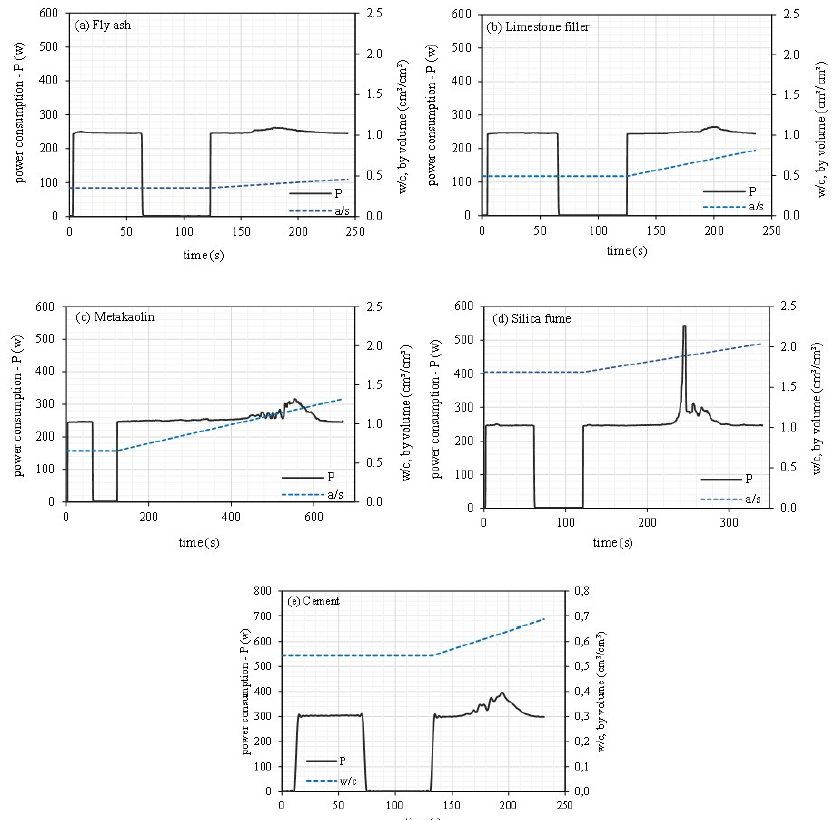
Figure 9. Mixing energy test results, with 0.5ml/s water additions for (a) Fly ash, (b) Limestone filler, (c) Metakaolin, (d) Silica and (e) Cement